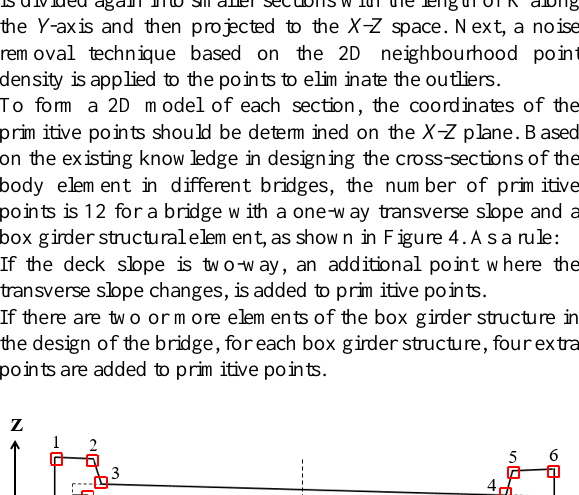
Figure 5. a: Fitting 2D primitive models to all sections of each patch, and b: 3D model of the body element.